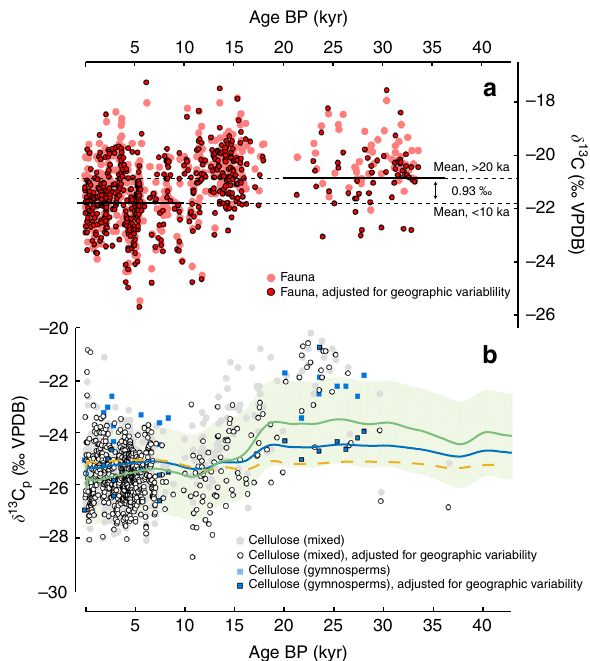
Fig. 2 Stable carbon isotope composition of terrestrial fossil archives over the last deglaciation, from predominantly C 3 ecosystems. a Faunal collagen from northwestern Europe and northern Eurasia from 33.4 kyr BP to early 20 th century. Light red circles show δ 13 C before adjustment for MAP, altitude and latitude. Dark red circles show adjusted δ 13 C, based on the regressions of Kohn 1 . Dark black lines indicate adjusted means of faunal δ 13 C before 20 kyr and after 10 kyr, which are − 20.85 ‰ and − 21.78 ‰ , respectively. b Plant cellulose δ 13 C p records from the Northern Hemisphere, 40.5 kyr BP to early 20th century, with model curves. Colour codes match legend in Fig. 1: light green, SJ-2012; blue, Voelker-2016g; dashed yellow, Farquhar-1982. SJ-2012 model is shown with 1 σ propagated uncertainties. Dark blue squares show gymnosperm data adjusted for geographic variability in MAP, altitude, and latitude. Light blue squares show raw gymnosperm data before adjustment. Filled white circles and grey circles show mixed species (either angiosperm or unidenti fi ed) before and after adjustment for geographic variability,